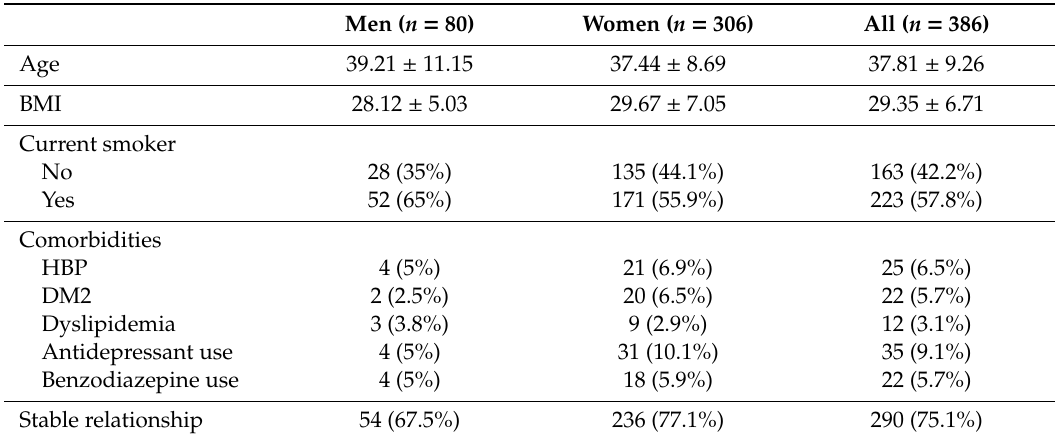
Table 1. Socio-demographic characteristics and comorbidities.